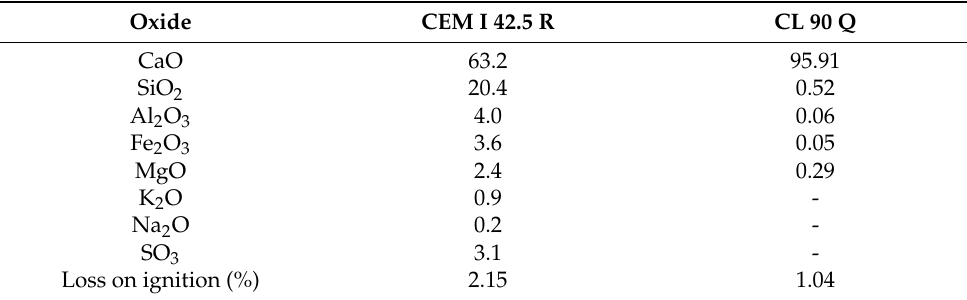
Table 1. Oxide compositions of OPC and calcium quicklime powder, %.